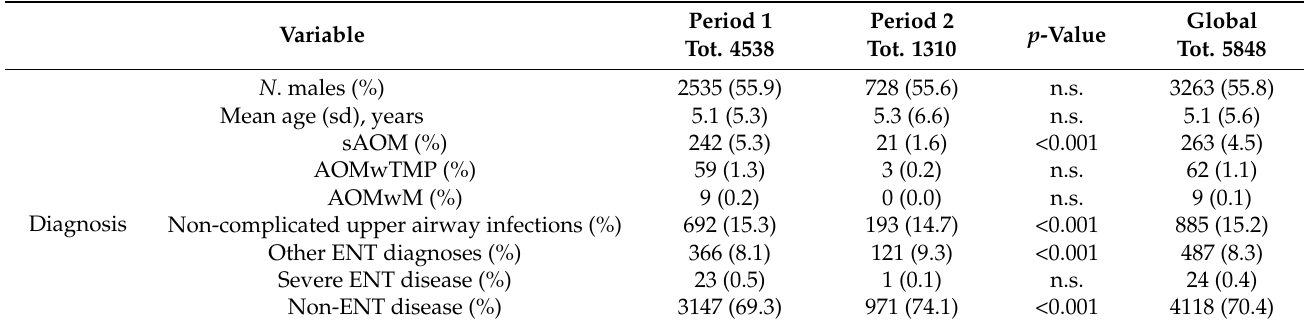
Table 2. Demographic and clinical characteristics of the population.